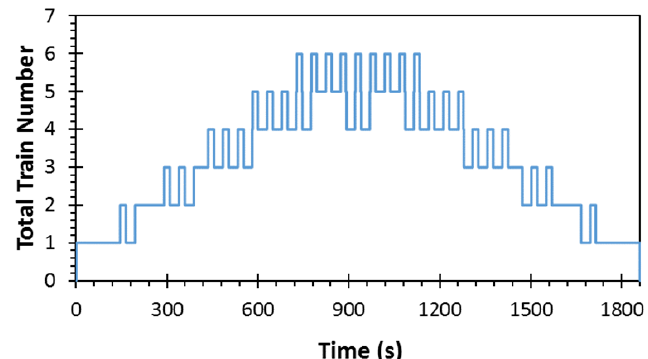
Figure 5. Number of trains running on a single track against the simulation time.